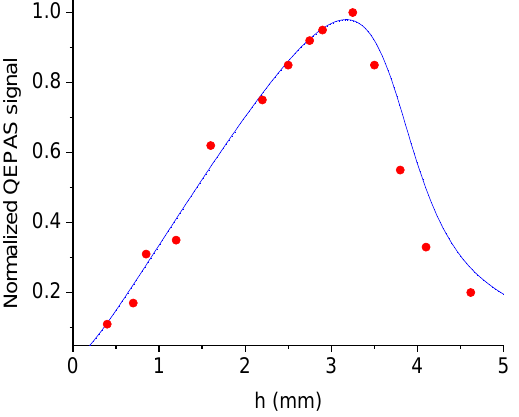
Figure 8. Normalized experimental results (dots) of the QEPAS signals as a function of the vertical position of the QTF. Data are obtained by detecting a concentration of 2% H N at 75 Torr and by using an on-beam QEPAS sensor system configuration. The solid line 2 is the best fit curve obtained using Equation